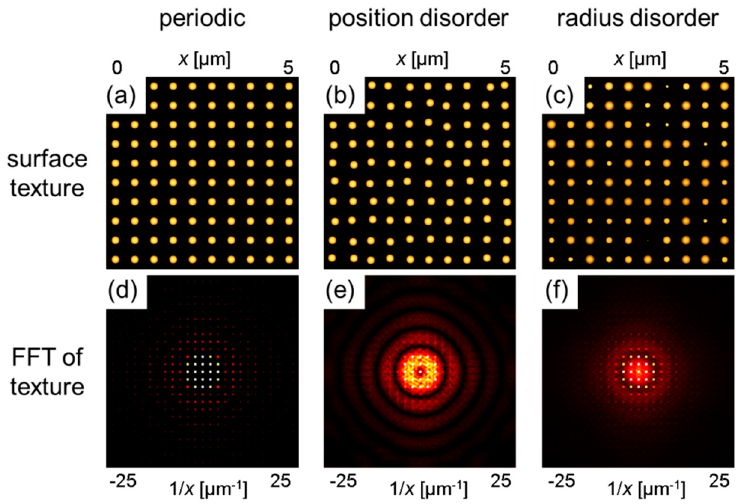
Figure 2. ( a–c ) Representative topography images of the periodic grating texture, the texture with introduced position disorder and with radius disorder, respectively. ( d–f ) The corresponding images of the 2D-Fast Fourier transformation (FFT) applied to the textures shown in ( a–c ), respectively.